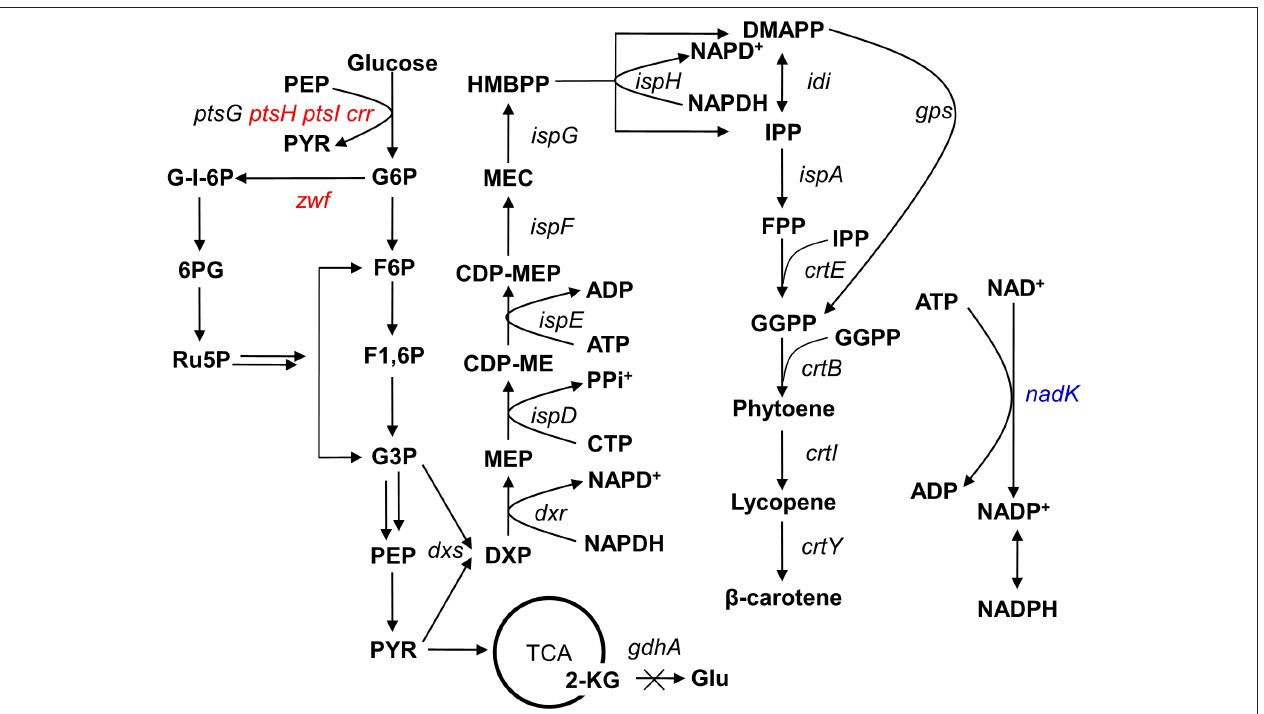
FIGURE 1 | Simplified carbon metabolic profile of the producing Escherichia coli strain. The heterologous genes gps and crtEBIY were integrated into the E. coli genome at the ldhA locus to introduce the β -carotene pathway ( Li et al., 2015). The genetic manipulations in this study are shown in colored fonts, where red represents gene deletion and blue represents gene overexpression. The multiple arrows represent multiple reactions. G6P, glucose-6-phosphate; F6P, fructose-6-phosphate; F1,6P, fructose-1,6-bisphosphate; G-l-6P, gluconolactone-6-phosphate; G3P, glyceraldehyde-3-phosphate; PEP, phosphoenolpyruvate; PYR, pyruvate; 6PG, 6-phosphogluconate; Ru5P, ribose-5-phosphate; 2-KG, 2-ketoglutaric acid; Glu, glutamic acid; DXP, 1-deoxy- D -xylulose-5-phosphate; MEP, 2C-methyl- D -erythritol-4-phosphate; CDP-ME, 4-diphosphocytidyl-2C-methyl- D -erythritol; CDP-MEP, 4-diphosphocytidyl-2C-methyl- D -erythritol-2-phosphate; MEC, 2C-methyl- D -erythritol-2,4-cyclodiphosphate; HMBPP, 1-hydroxy-2-methyl-2-(E)-butenyl-4-diphosphate; IPP, isopentenyl diphosphate; DMAPP, dimethylallyl diphosphate; GPP, geranyl diphosphate; FPP, farnesyl diphosphate; GGPP, geranylgeranyl